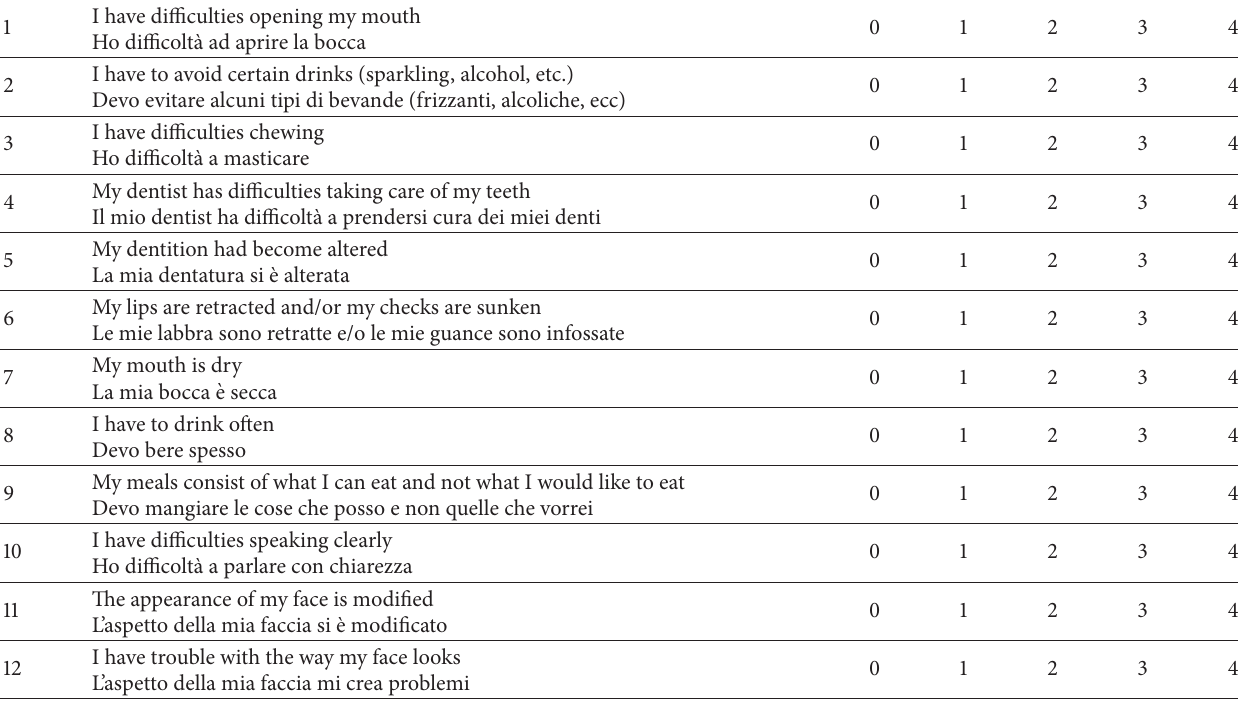
Table 2: Italian version of Mouth Handicap in Systemic Sclerosis Scale (IvMHISS) assesses the handicap with mouth disability in SSc. It consists of 12 items (each scored 0–4): 0 Never (Mai); 1 Rarely (Raramente); 2 Occasionally (Occasionalmente); 3 Often (Spesso); 4 Always (sempre).